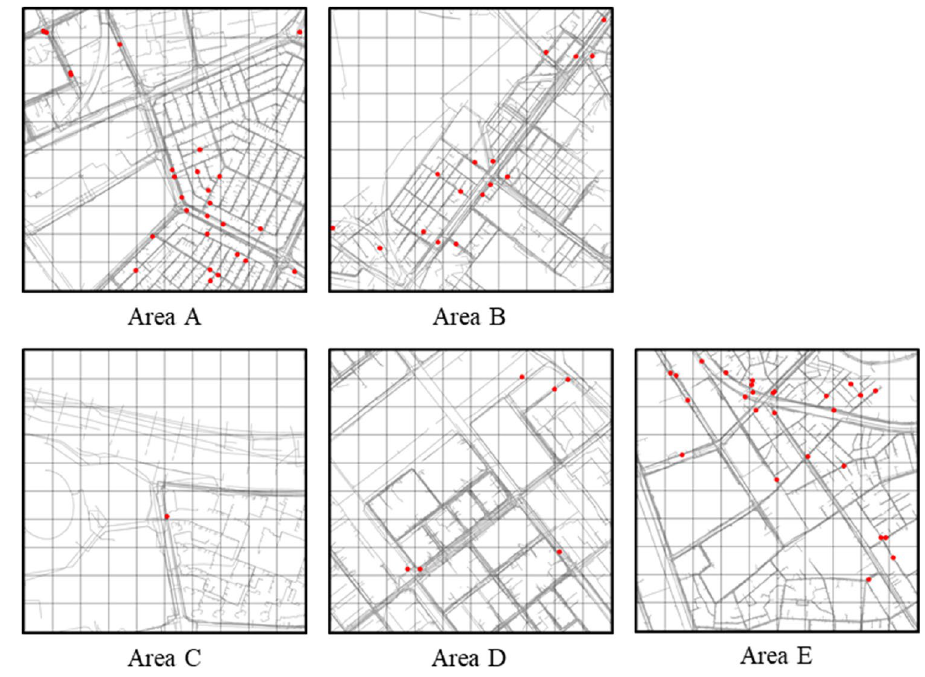
Figure 1. Points of ground sink